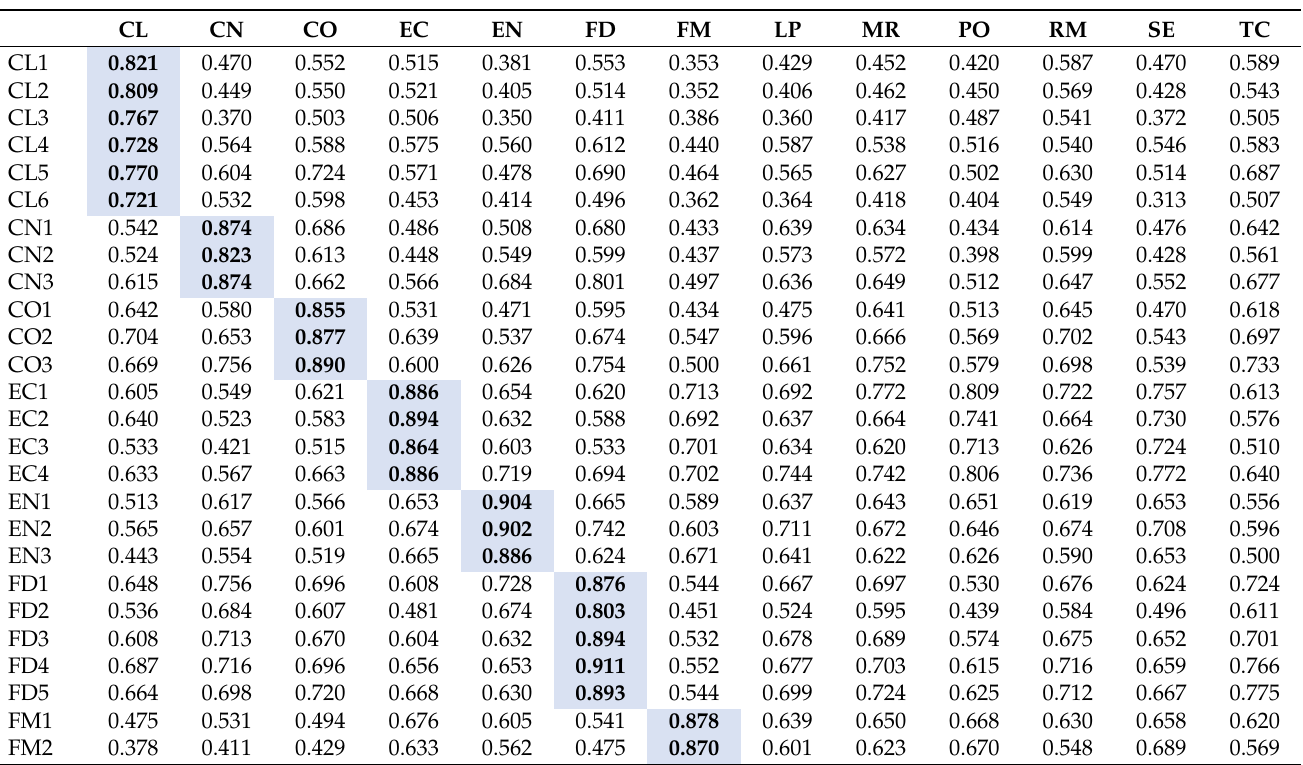
Table 10. Discriminant validity—Cross-loading for risk